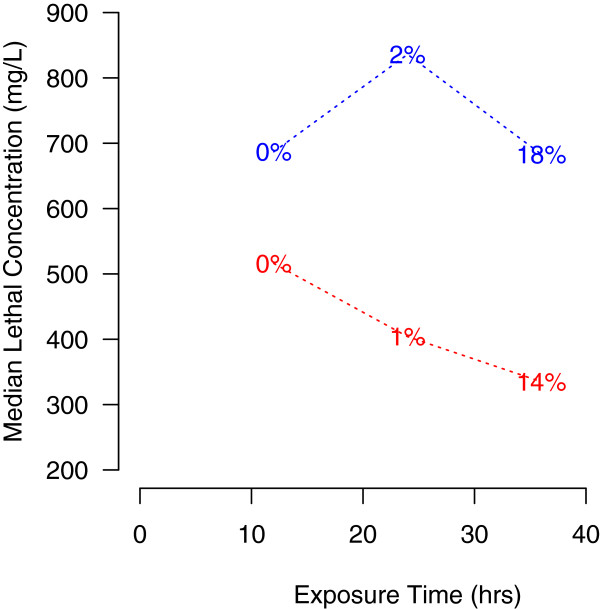
Dependence of ammonia tolerance, expressed by the median lethal concentration (LC50), on duration of exposure to the toxicant in Anopheles gambiae molecular forms (form M: blue; form S: red). Percent figures represent the larval mortality observed in control batches of each form at different exposure intervals.